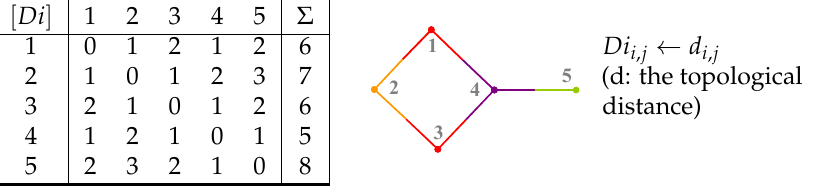
Figure 3. Distance matrix on Figure 1. The additional column ( Σ ) collects the sum of the distances (at all vertices) for each vertex and can also be used to discriminate vertices (the vertices are represented with different colors accordingly in Figure 3) and as a criterion that can be used to create a vertices partition (for Σ j D i , j the partition is in four groups: { 4 } , { 1, 3 } , { 2 } , { 5 } —here, the groups are ordered according to the ascending value of Σ j D i , j ).